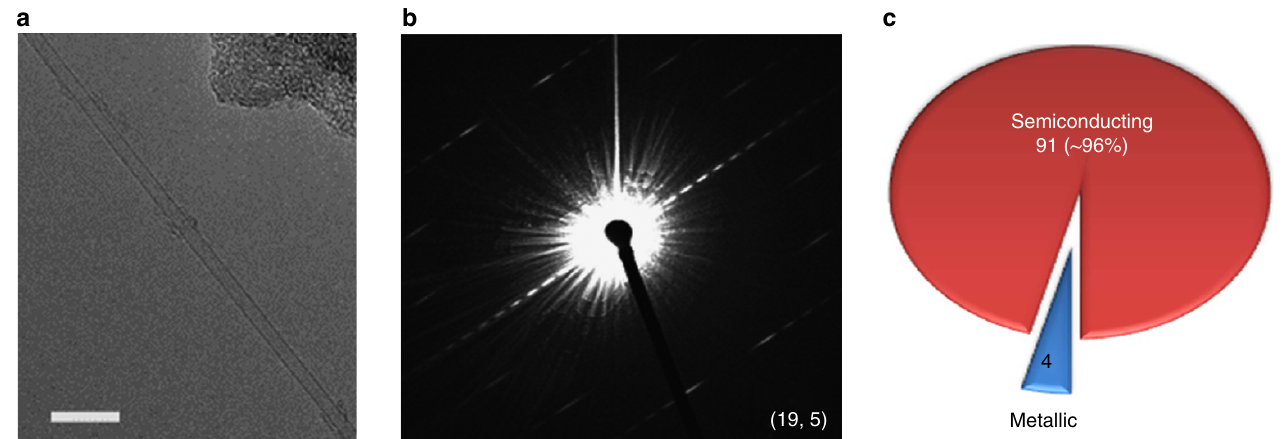
Figure 5 | Electron diffraction of the SWCNTs. ( a ) Typical TEM image of an isolated SWCNT. Scale bar, 10nm. ( b ) Electron diffraction pattern of the SWCNT shown in a , the chirality of which is assigned as (19, 5). ( c ) A pie chart showing the content of s- and m-SWCNTs based on electron diffraction measurements of a total of 95